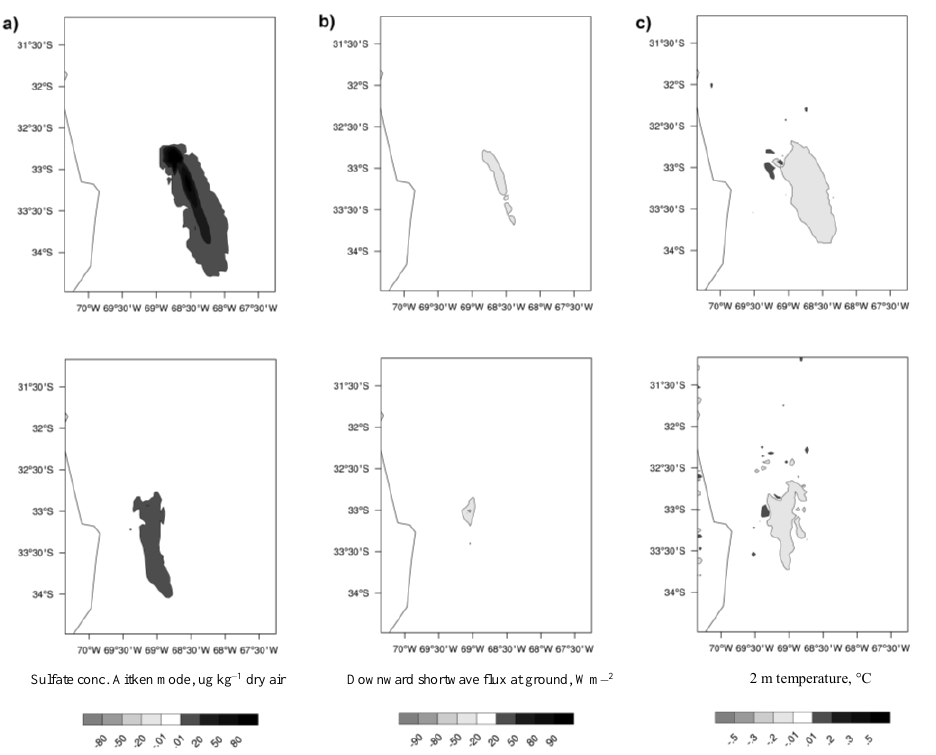
Fig. 8. Anomalies calculated as ID1 − Test_Control at 4 km a.s.l. (upper panel) and ID2 − Test_Control at 2 km a.s.l. (lower panel) on January 8, 2012 at 12:00 LT for: a) Aitken-mode SO 42 − concentration; b) surface incident shortwave radiation; c) surface